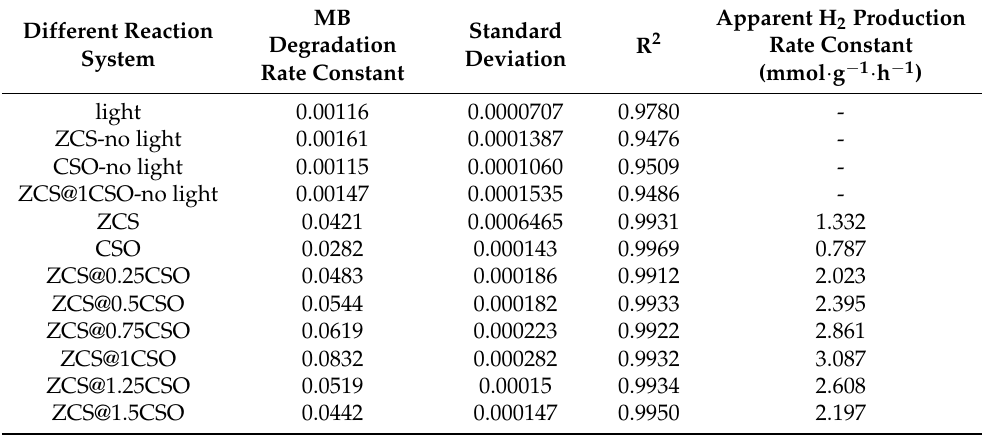
Table 1. The photocatalytic kinetic analysis results.